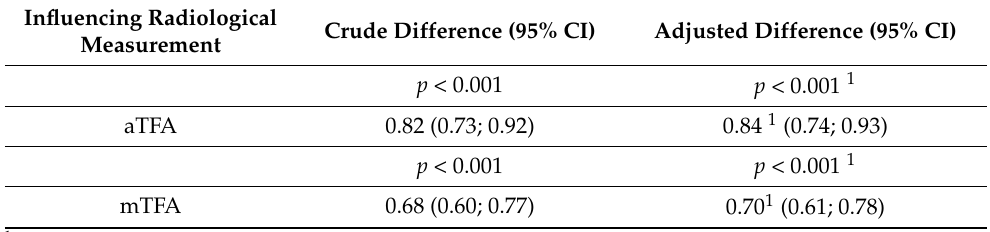
Table 4. Correlations between photographic measurements and radiographic measurements as crude correlation and adjusted for